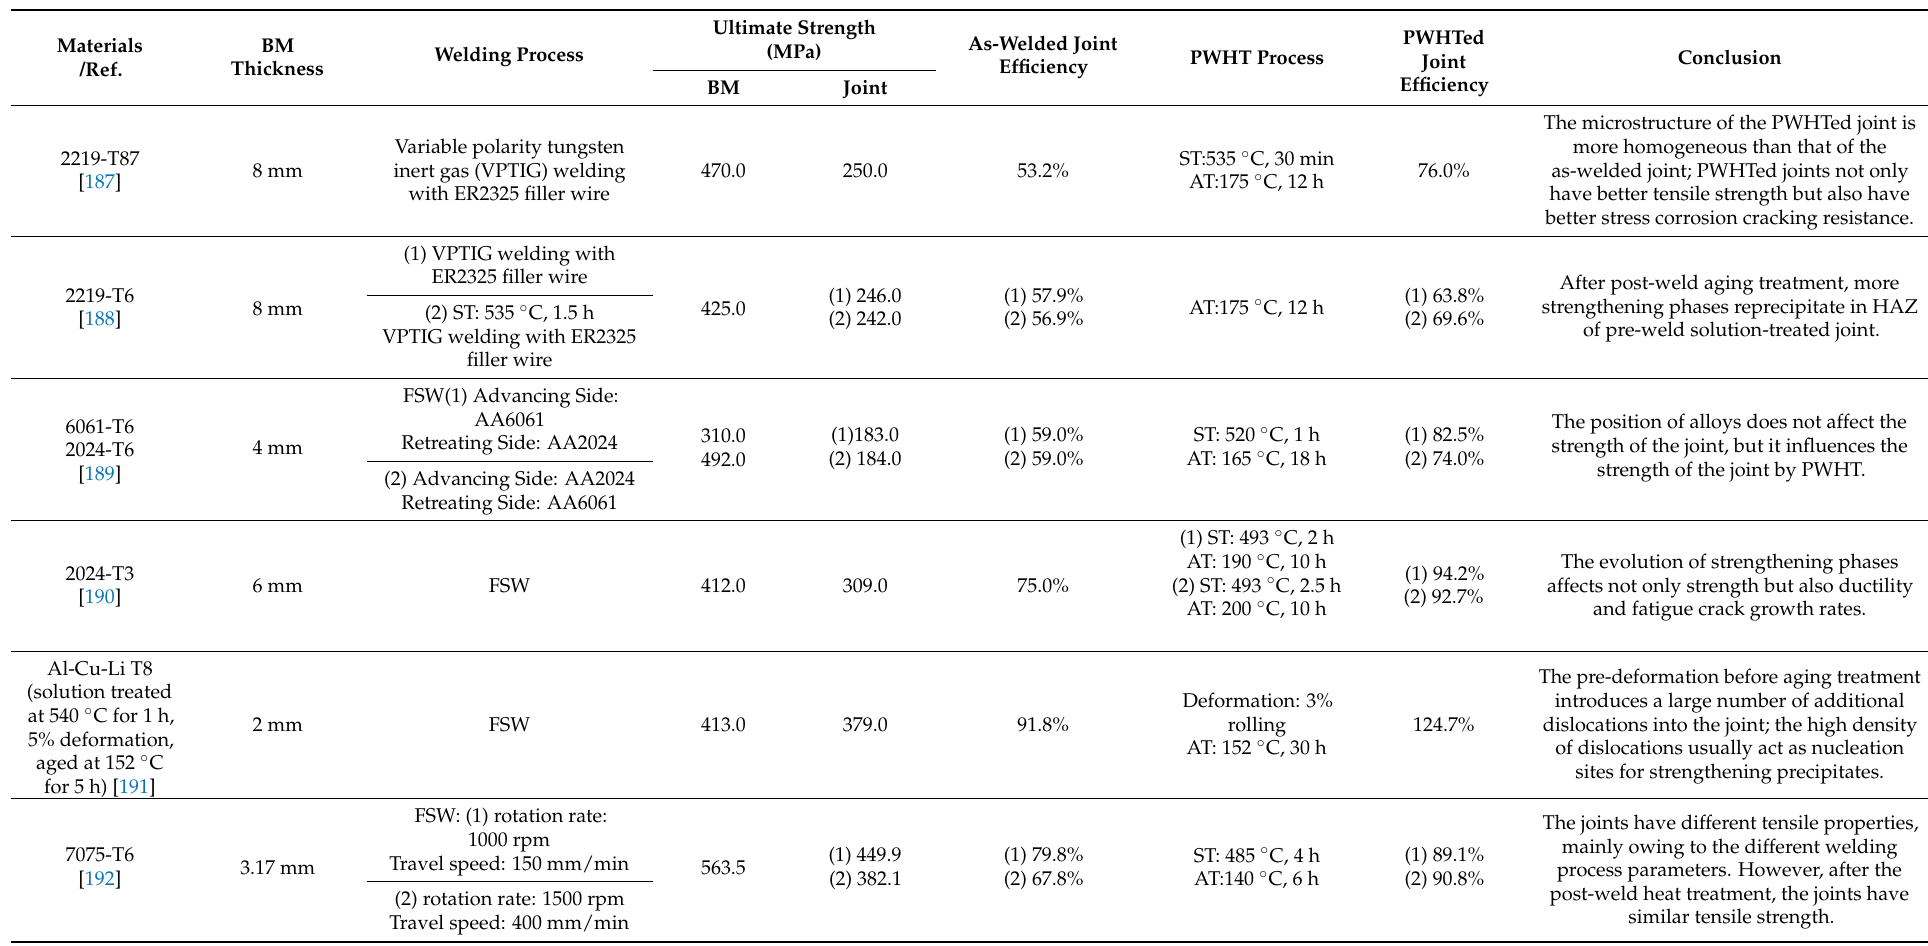
Table 10. The mechanical properties of joints subjected to post-weld heat treatment in the literature (ST: solution treatment, AT: aging treatment). Materials